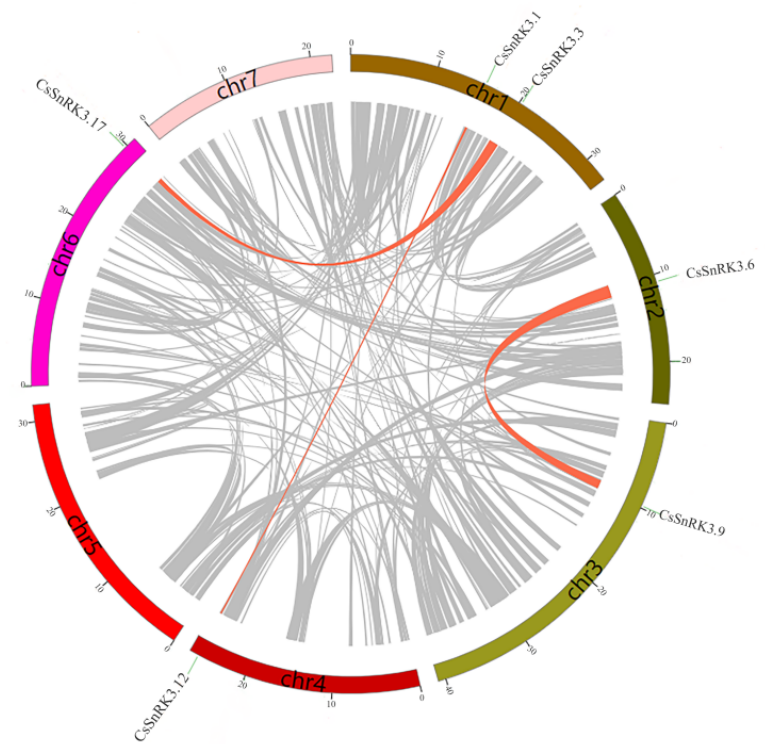
Figure 3. Chromosomal locations of CsSnRK genes. The length of chromosomes can be estimated using the scale on the left.